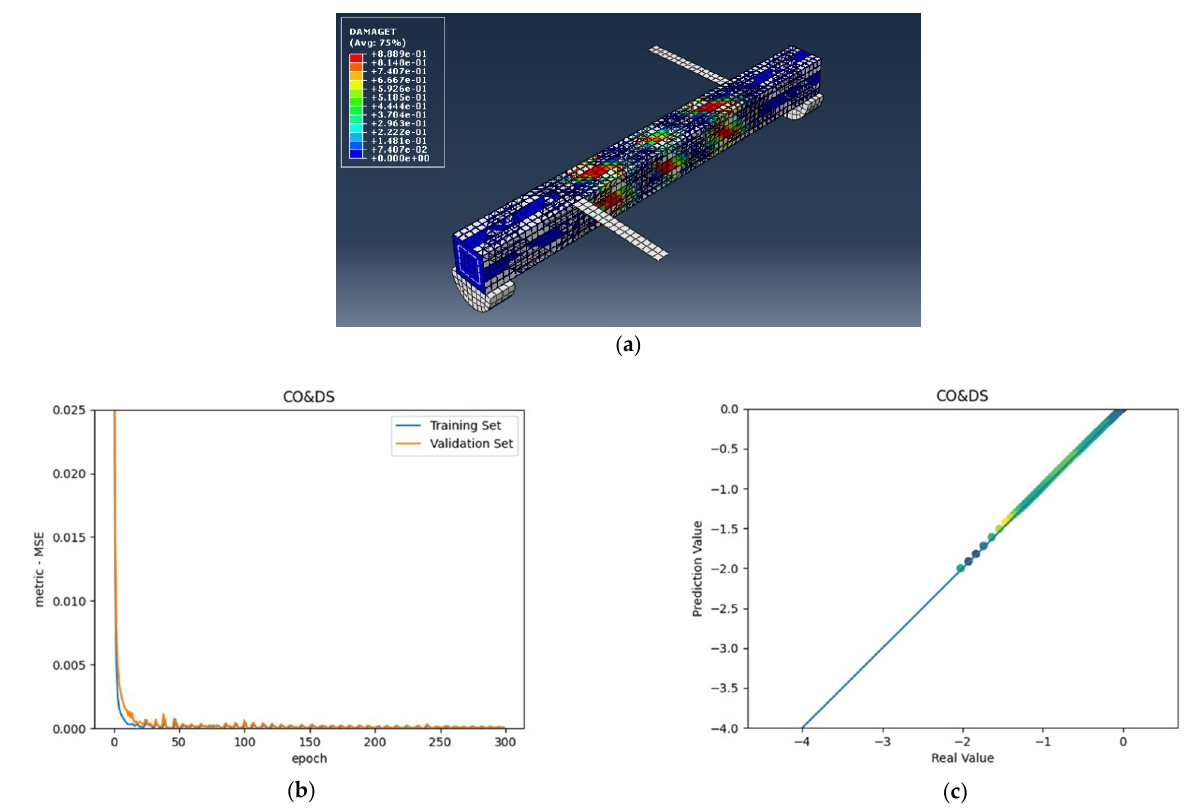
Figure 11. ( a ) CO and DS beam under combined torsion and bending, ( b ) Training loss, ( c ) Accu- racy.